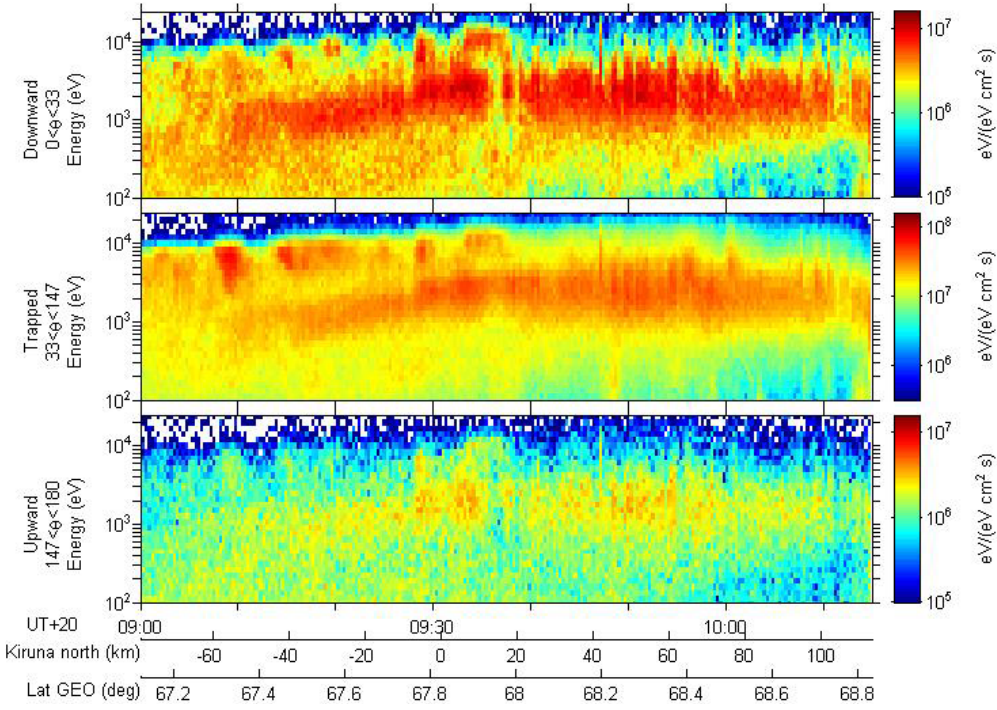
Fig. 6. Same as Fig. 5 but for the time interval 20:09:00–20:10:27UT and with a different energy flux scale.